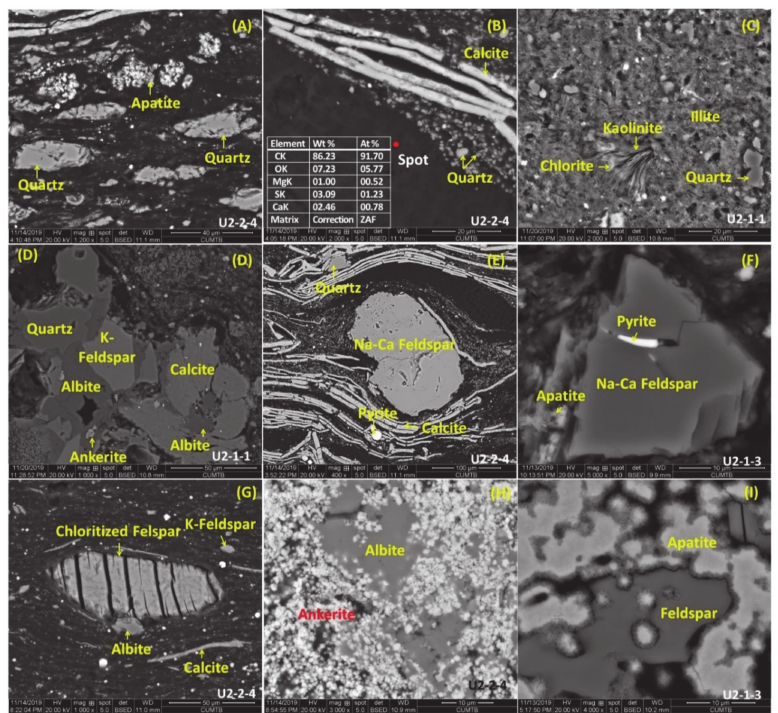
Figure 5. SEM backscattered electron images of OS2 oil shales from the Liangjia Coal Mine. ( A ) Quartz as cell filling; ( B ) fine quartz grains scattered in the organic matter matrix; ( C ) quartz particle, broom-like kaolinite in illite matrix; ( D ) quartz, feldspar, calcite, and ankerite in massive aggregates; ( E ) a well-rounded detrital feldspar grain; ( F ) pyrite filling the cleat of feldspar; ( G ) chloritized feldspar in the matrix of organic matter; ( H ) massive albite surrounded by ankerite fine particles; ( I ) feldspar co-exists with